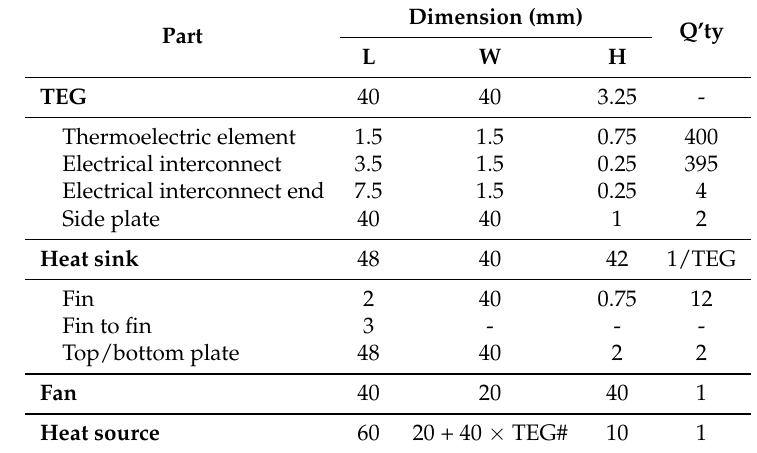
Table 1. Dimensions of all components.